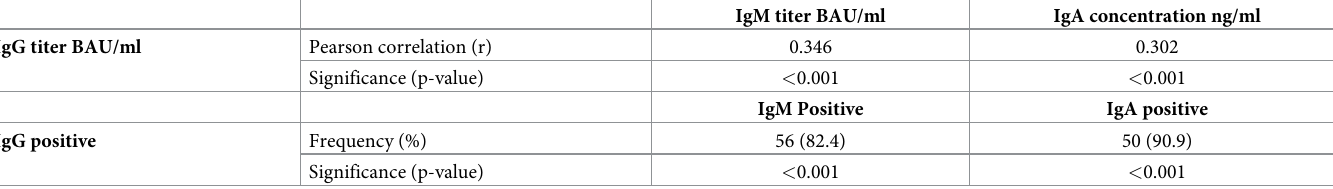
Table 4. Correlation between different types of immunoglobulins among COVID-19